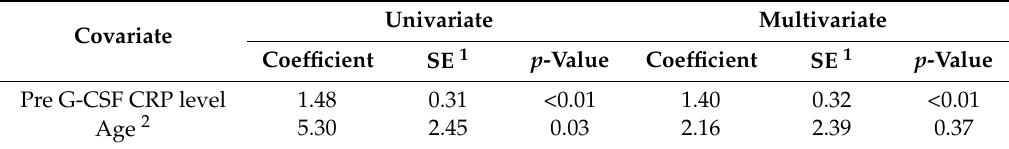
Table 1. A summary of the linear regression model of the effects of pre-G-CSF CRP levels and age on CRP levels after granulocyte colony-stimulating factor (G-GSF) administration. Age was initially entered as three different dummy variables corresponding to the second, third, and fourth quartile. Only age above or below 57 years had a significant effect on CRP levels in univariate analysis. Univariate Multivariate Covariate Coefficient SE 1 p -Value Coefficient SE 1 p -Value Pre G-CSF CRP level 1.48 0.31 <0.01 1.40 0.32 <0.01 Age 2 5.30 2.45 0.03 2.16